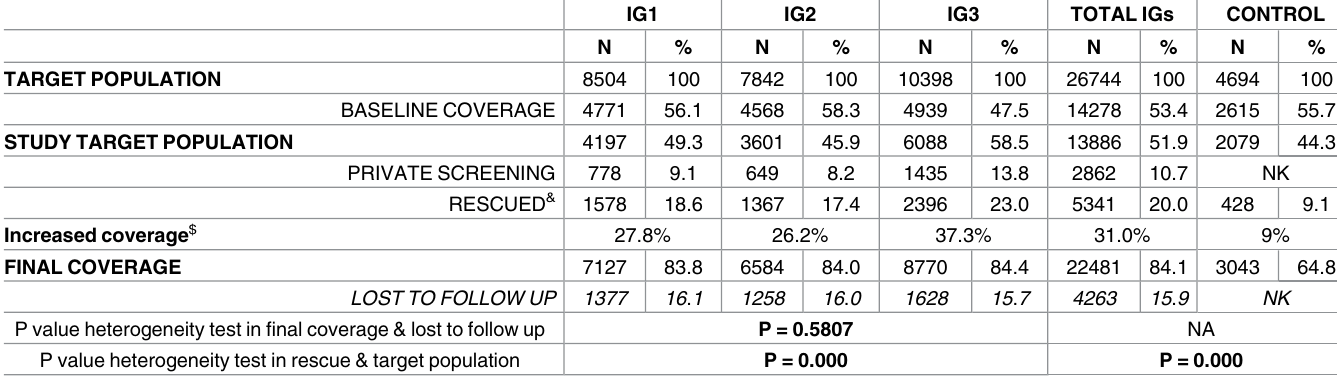
Table 1. Cervical cancer screening coverageat baseline, those referring a private gynecologist and rescued coveragepost intervention and final population coverageattained by intervention groups and the control group at five and a half years *